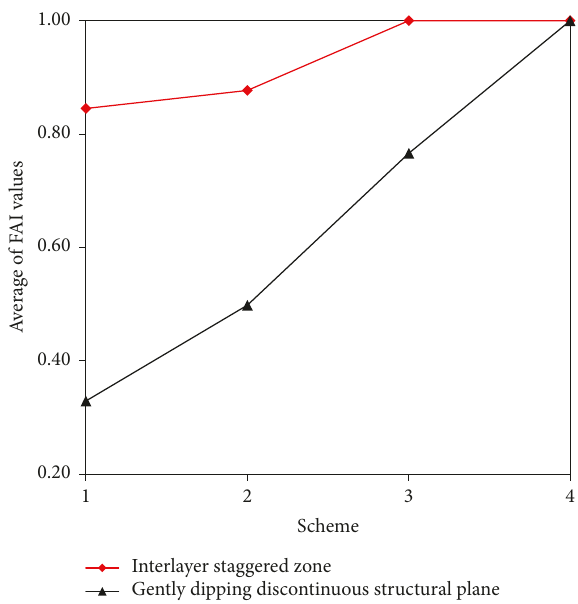
Figure 9: The average of FAI values of the potential sliding surface in each